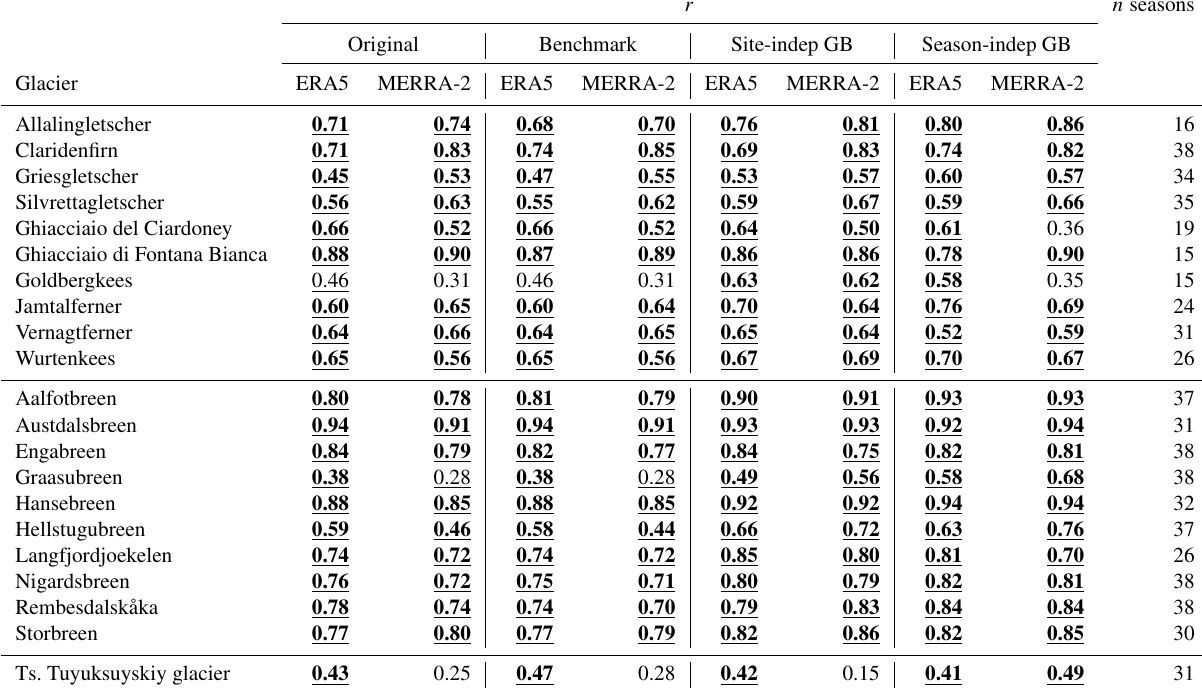
Table 2. Pearson correlation ( r [–]) between the reanalysis-based models and the glacier-wide B w over the accumulation seasons (temporal correlation) separated by regions. Only the glaciers with a minimum of 15 seasons with B w data are shown (i.e. no glacier in western Canada). The significance of the correlation is based on Student’s t distribution. The level of the correlation significance is indicated as follows: normal font, not significant ( p value > 0 . 10); underlined, significant ( p value ≤ 0 . 10); and underlined and bold, highly significant ( p value ≤